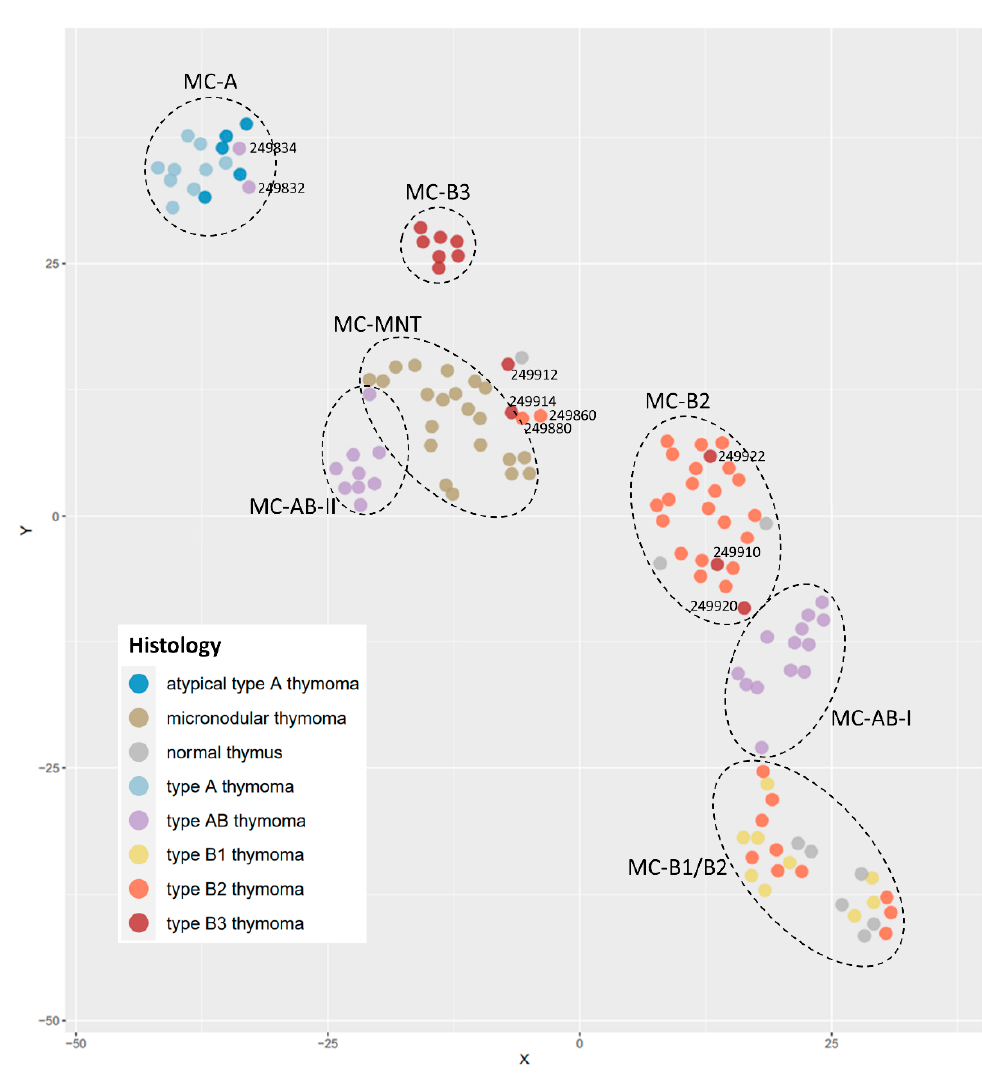
Figure 1. DNA methylation-based thymoma classification colored by the histological diagnosis. Circles indicate seven different methylation groups (MC-A; MC-AB-I; MC-AB-II; MC-B1/B2; MC-B2; MC-B3; and MC-MNT) established by t-Distributed Stochastic Neighbor Embedding (t-SNE) dimensionality reduction. Each of the MC-groups is mainly composed of one histological subgroup (displayed by different colors) despite some remarkable features: 1. A-thymomas cluster together with atypical A-thymomas; 2. AB-thymomas are separated into two clusters that were characterized histologically by a rare monophasic and prototypic bi-phasic growth pattern, respectively; and 3. B2-thymomas are separated into two clusters that were characterized histologically by prototypic B2 and “B1-like” B2-thymomas, respectively. MC-MNT forms a separate methylation entity but has poorly defined boundaries. Normal thymus samples clustered mainly with B1/B2 thymomas, which most closely resemble normal thymus cytologically and